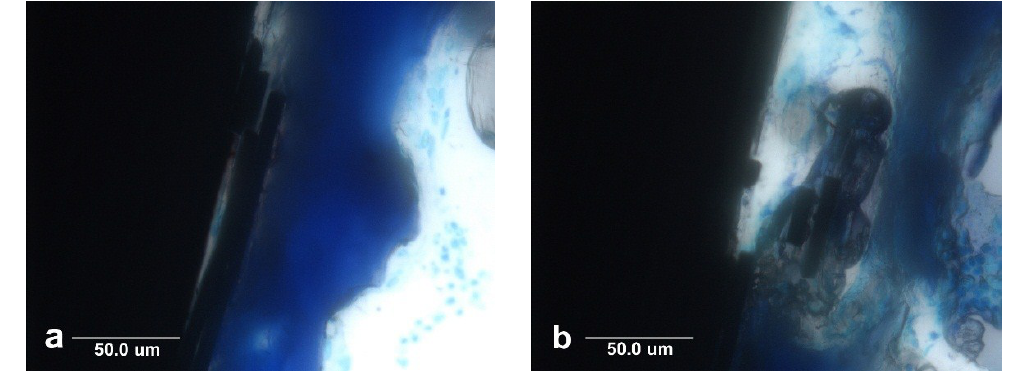
Figure 8. Lateral cross-sectional histology section at 40× magnification by toluidine blue of epoxy/carbon fiber PMC implant with broken carbon fibers pulled transversely away from the implant. ( a ) Carbon fibers are broken and pulled away from implant by bone in the transverse direction to open up small pore space at the PMC implant surface allowing minimal oxygen access; ( b ) After carbon fibers are split and pulled away from the PMC implant, bone osseointegrates entirely around small carbon fiber segments with a large pore remaining at the implant